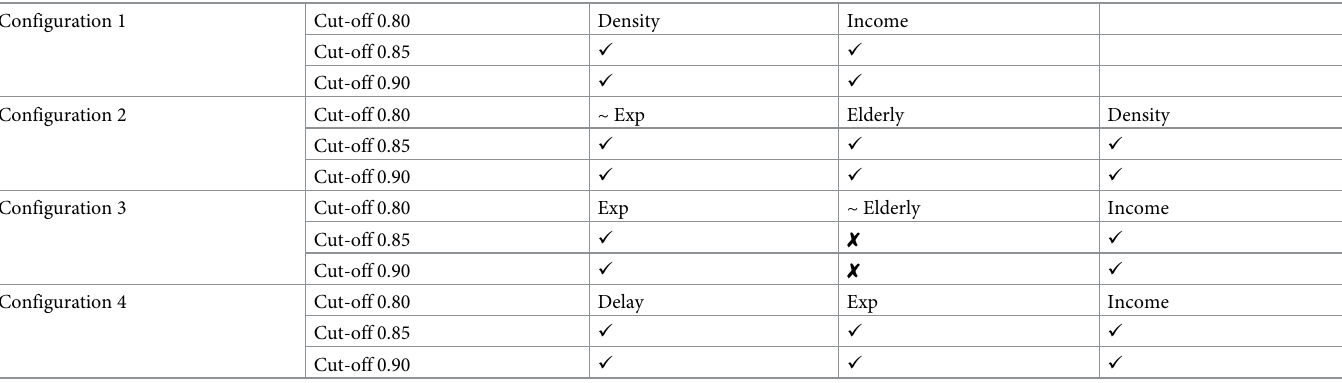
Table 6. Comparison of configurations for high YLL rate at different cut-offs.